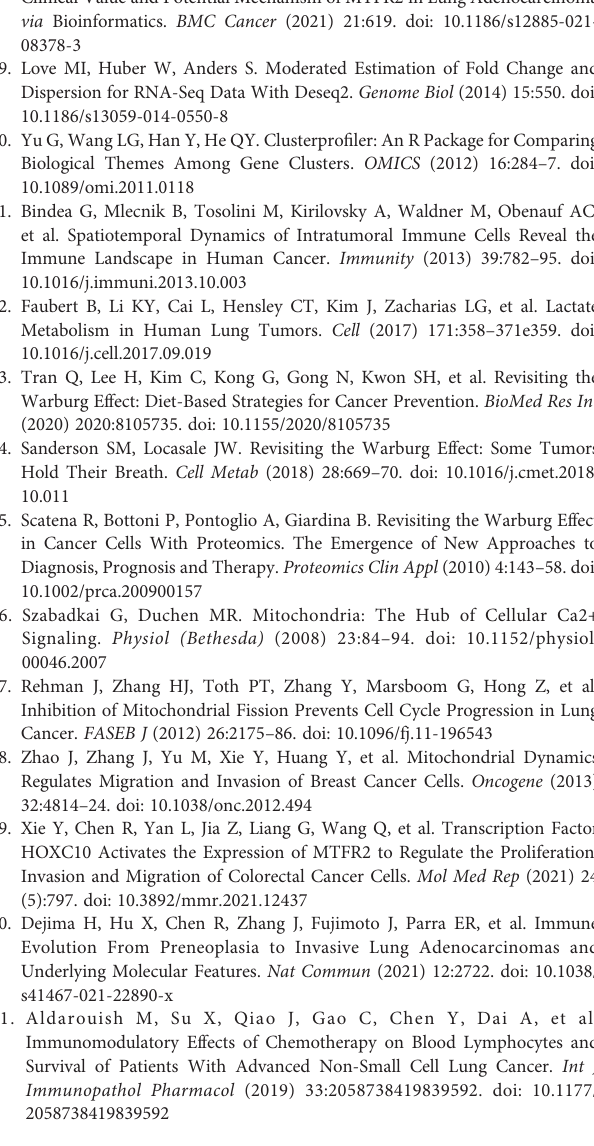
Supplementary Figure 2 | GSEA analysis showed cellular responses to external stimuli, signaling by RHO GTPASE, infectious disease, M phase, DNA replication, transcription regulation by P53, and translation, cellular response to stress (A – H) . Supplementary Figure 3 | MTFR2 over-expression was positively associated with the Tgd cells (A) , NK CD56 dim cells (B) , T help cells (C) and aDCs (D) , while was signi fi cantly negatively associated with the mast cells (E) , Th17 cells (F) , Tfh cells (G) , NK cells (H) and CD8 T cells (I)